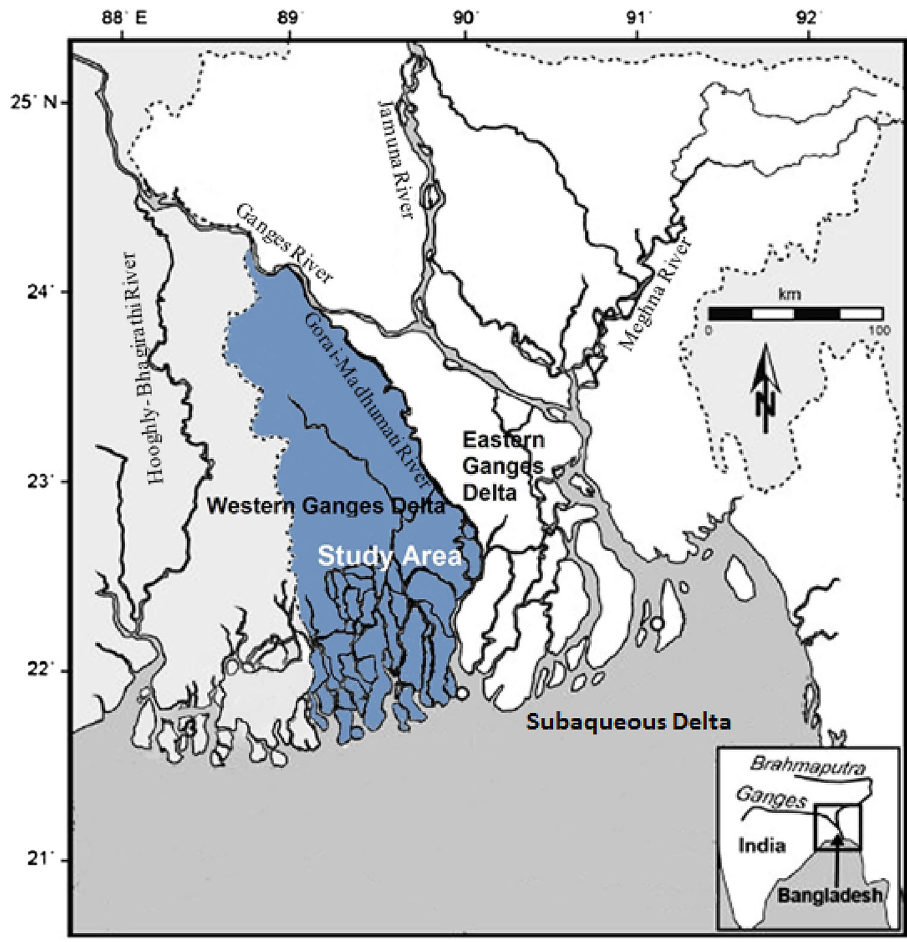
Fig. 1 Location map of the